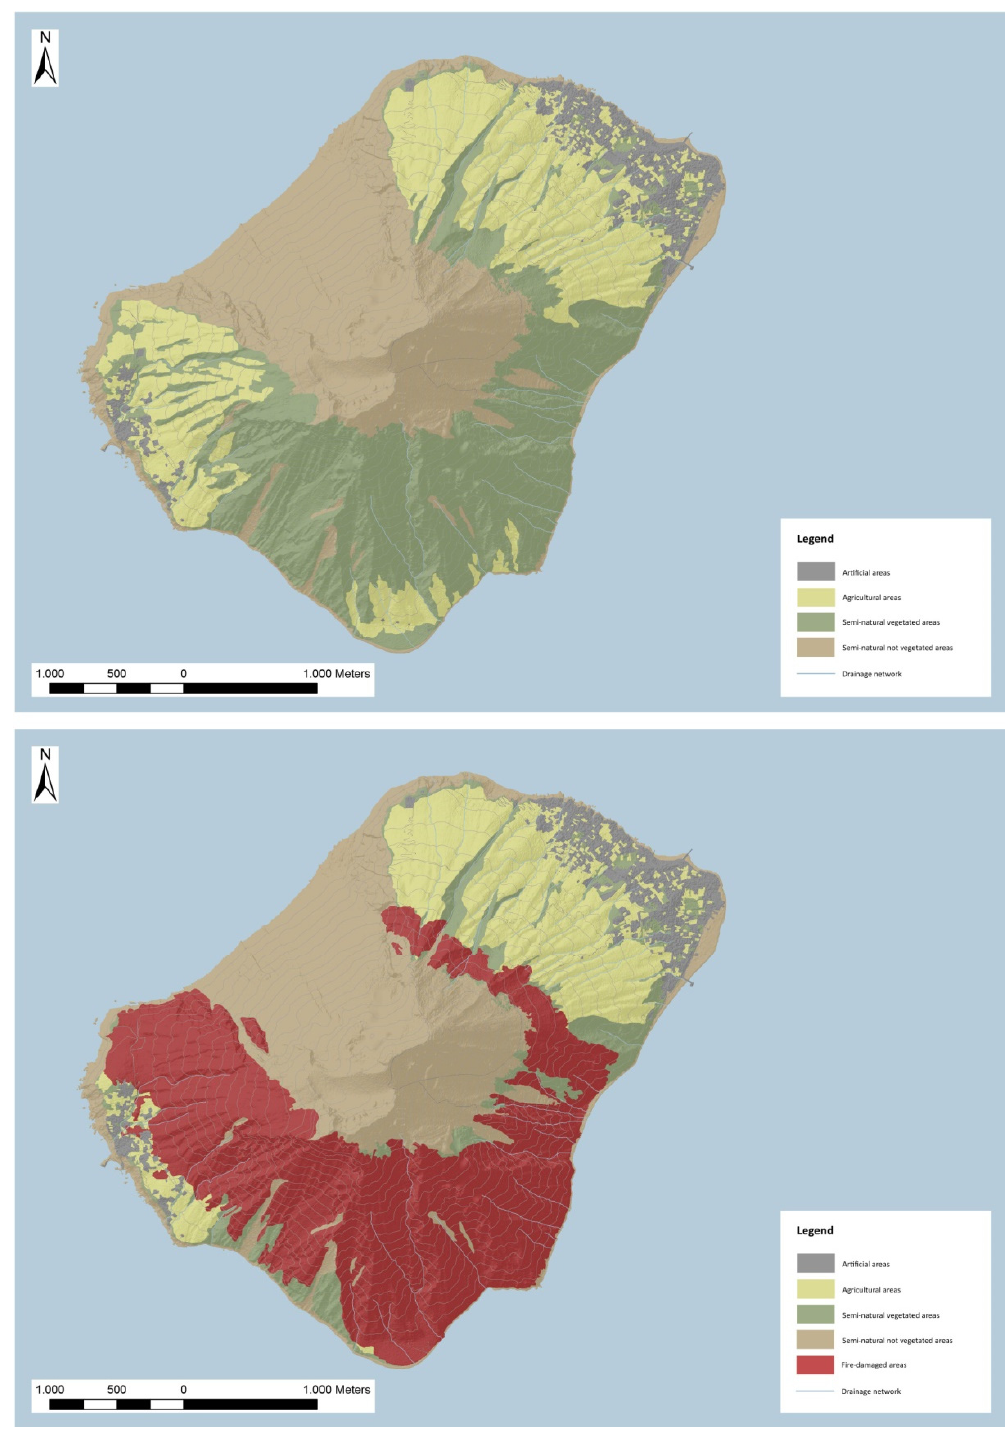
Figure 6. Land cover map (LC) pre ‐ eruption (2018) and post ‐ eruption (2019).